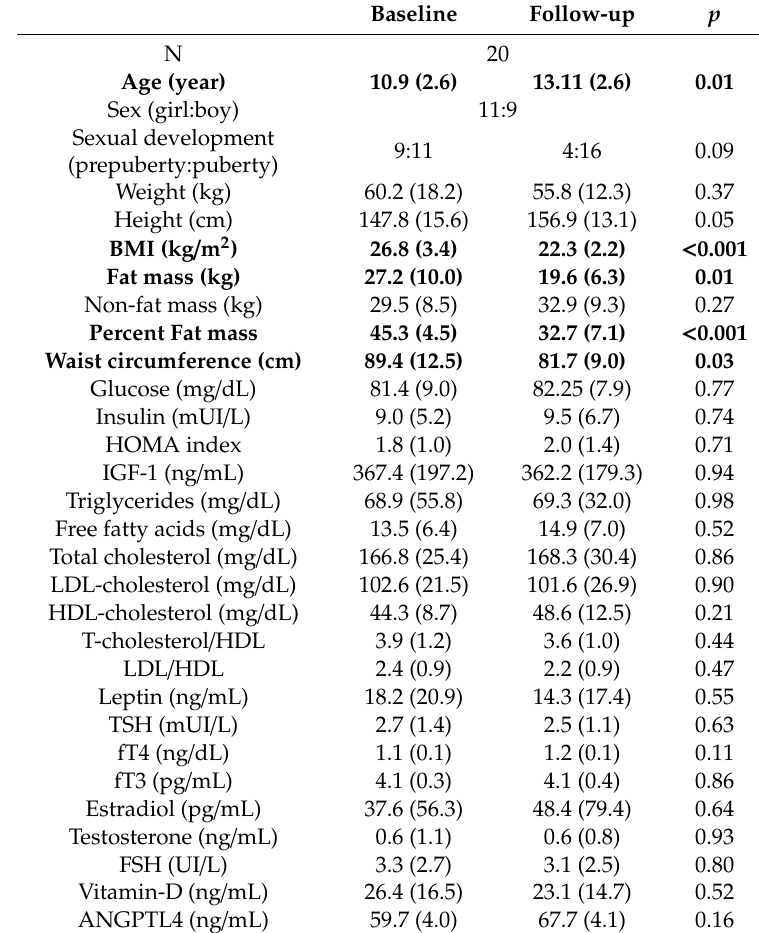
Table 3. Longitudinal e ff ects on anthropometric and biochemical characteristics in participants from interventional